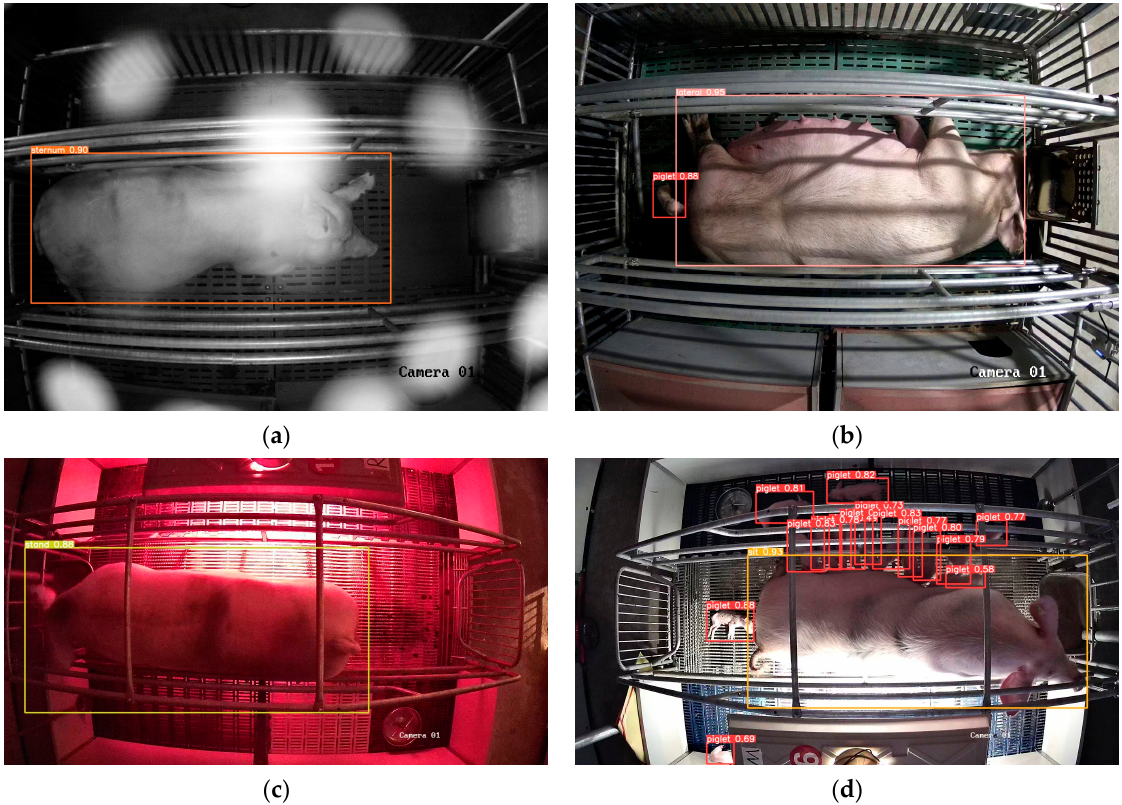
Figure 7. Complex scenarios image test effect. ( a ) Complex light, ( b ) First piglet born, ( c ) Different color of heat lamp, ( d ) Turn on heat lamp at night. Table 2. Test situation of YOLOv5s model in complex scenarios.